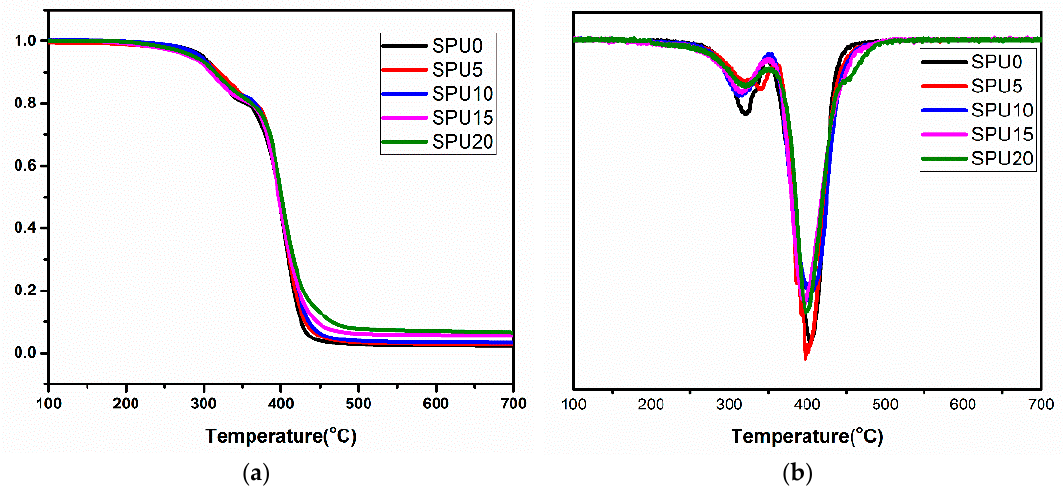
Figure 12. TGA ( a ) and DTG ( b ) curves of the SPU film samples.